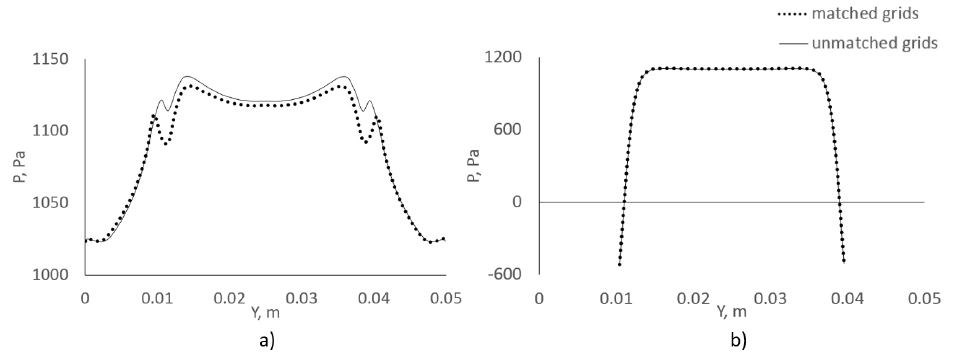
Figure 13. Profile of pressure at the control sections: ( a ) section A1, ( b ) section A2.